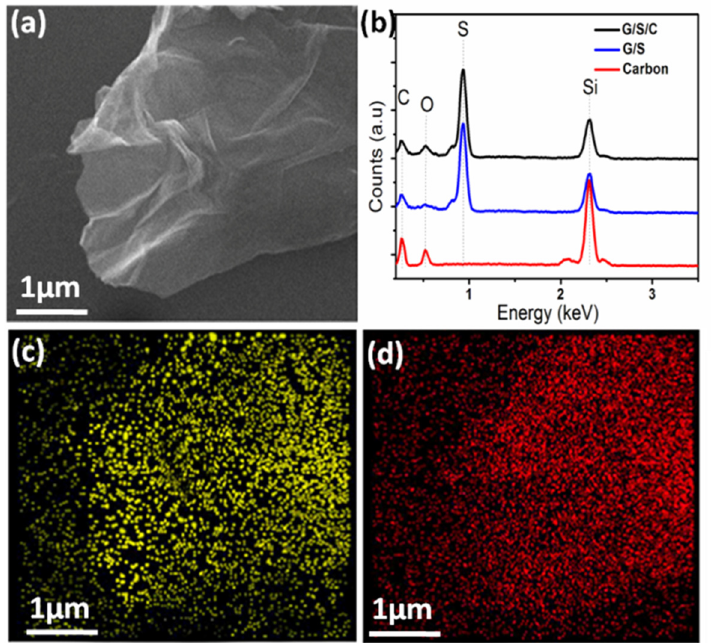
Figure 2. ( a ) SEM image of G/S/C composite; ( b ) EDS of G/S/C composite, G/S composite and carbon derived from β -cyclodextrin; ( c ) Elemental mapping of S in the region shown in ( a ); ( d ) Elemental mapping of C in the region shown in ( a ).